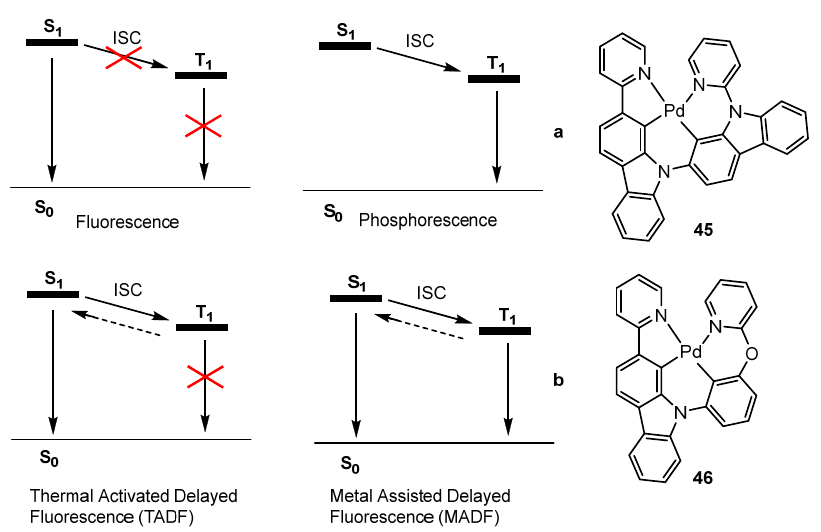
Figure 15. Illustration of the various emission mechanisms for organic emitters. Adapted from [78,79].